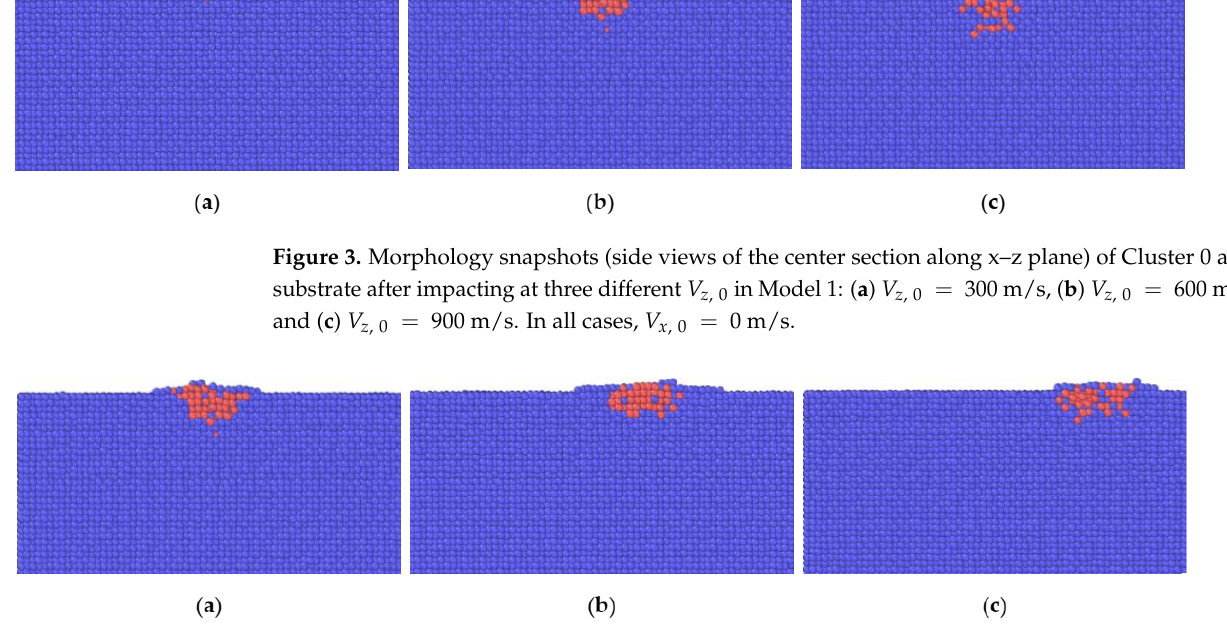
Figure 4. Morphology snapshots (side views of the center section along x–z plane) of Cluster 0 and substrate after impacting at three different V x , 0 in Model 1: ( a ) V x , 0 = 0 m/s, ( b ) V x , 0 = 100 m/s and ( c ) V x , 0 = 200 m/s. In all cases, V z , 0 = 600